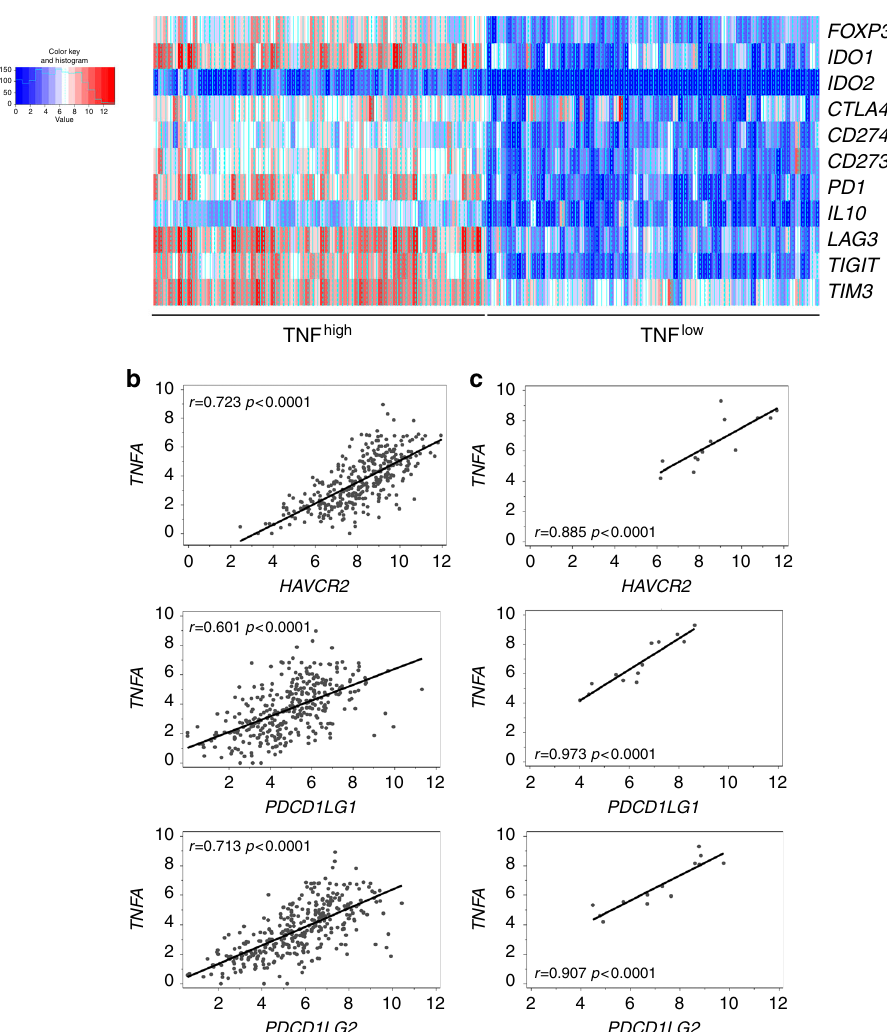
Fig. 7 TNF expression is associated with an immune escape gene signature in human metastatic melanoma. a Heatmap for a selected list of genes encoding immune escape proteins in metastatic melanoma patients from the TCGA melanoma cohort ( n = 342), exhibiting high (80th percentile) and low (20th percentile) TNF expression in melanoma samples. Genes were clustered using a Euclidean distant matrix and average linkage clustering. b and c Correlation analysis between the expression of HAVCR2 (encoding TIM-3), PDCD1LG1 (encoding PD-L1), PDCD1LG2 (encoding PD-L2) and TNFA (encoding TNF) in melanoma samples from metastatic melanoma patients from the TCGA cohort ( n = 342) ( b ) and from patients treated with anti-PD-1 (our analysis of data published in ref. 23 ) ( n = 13) ( c